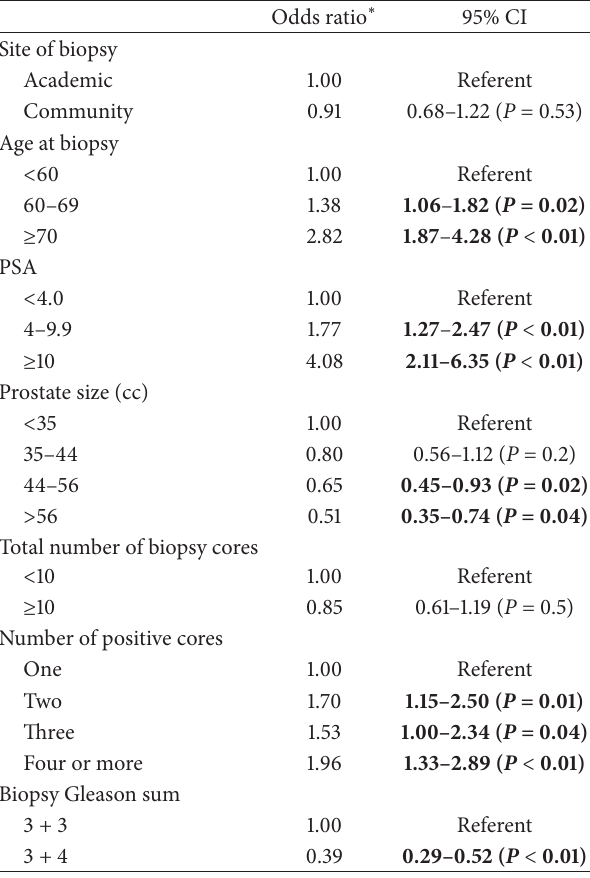
Table 3: Multivariate logistic regression for risk of Gleason upgrad- ing at radical